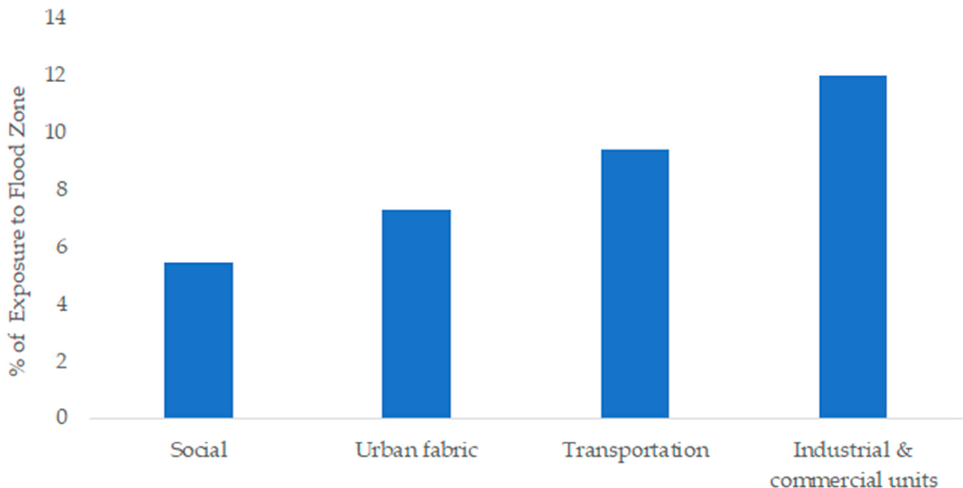
Figure 5. The ratios of residential areas and infrastructure located in flood zones in Greece.